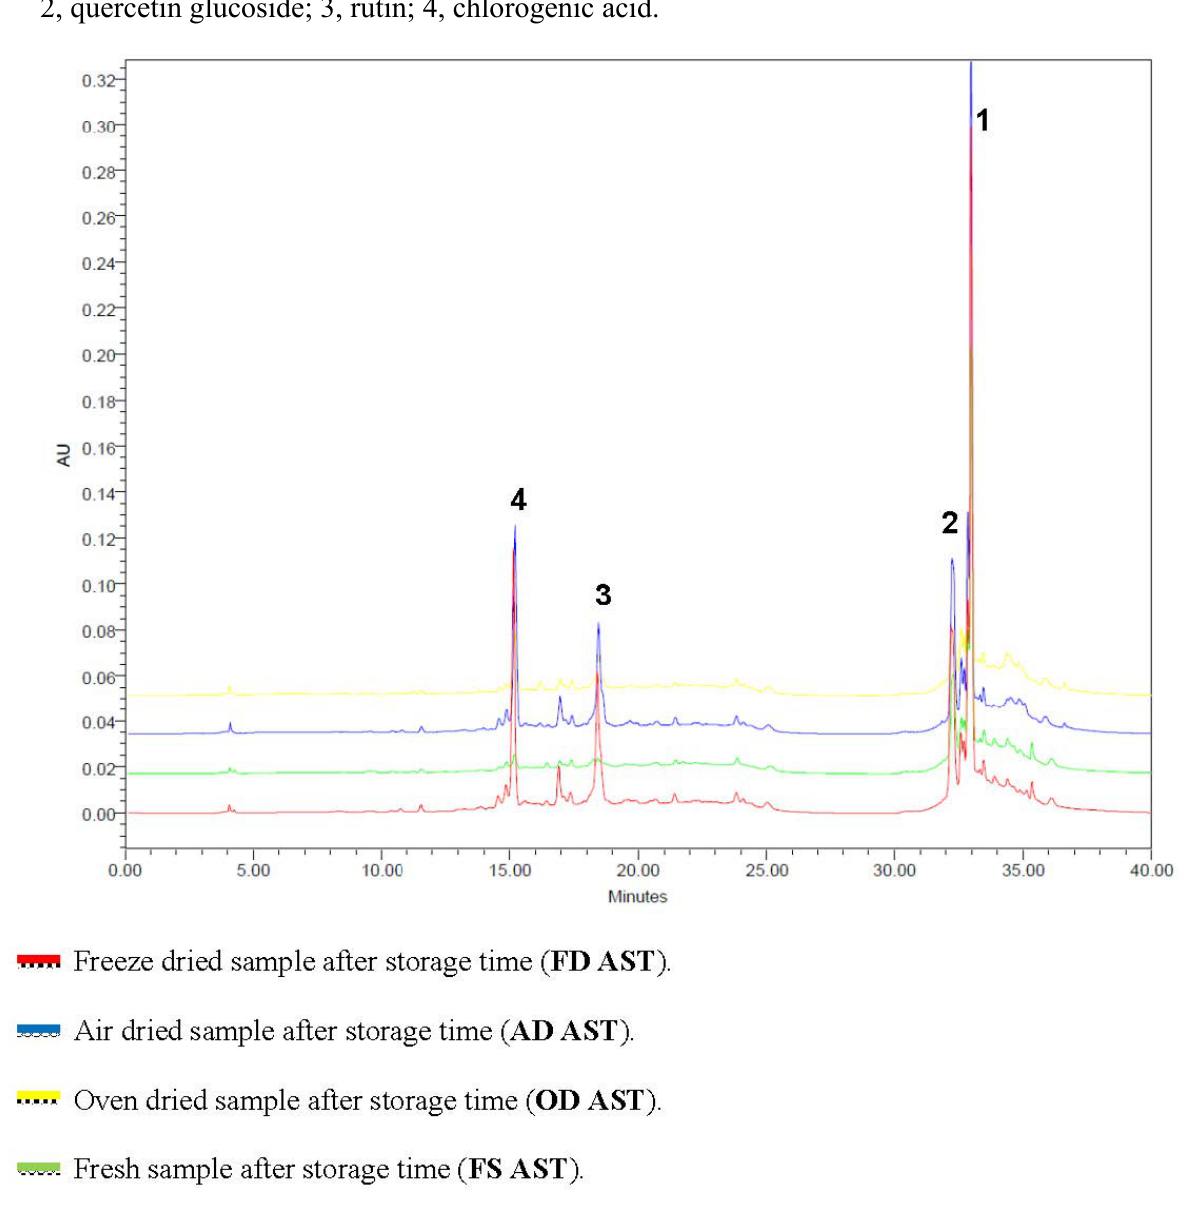
Figure 3. Overlaid chromatograms of C. caudatus samples stored for three months with different drying methods. AD AST: air-dried sample after storage time, FD AST: freeze-dried sample after storage time, OD AST: oven-dried sample after storage time and FS AST: fresh sample after storage time. Identified peaks: 1, quercetin rhamnoside; 2, quercetin glucoside; 3, rutin; 4, chlorogenic